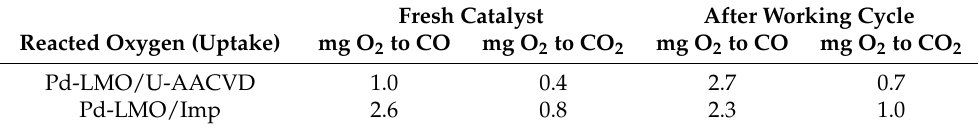
Table 3. Amounts of oxygen from the catalysts reacted with methane at 500 ◦ C in CH 4 /N 2 flow. Fresh Catalyst After Working Cycle Reacted Oxygen (Uptake) mg O 2 to CO mg O 2 to CO 2 mg O 2 to CO mg O 2 to CO 2